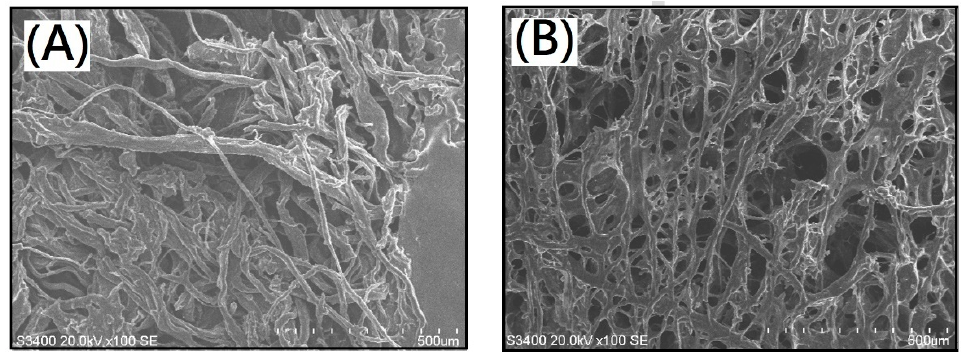
Figure 3. Macroscopic images of the composite scaffold membranes ( A ) AdE4N and ( B ) AdE4L.